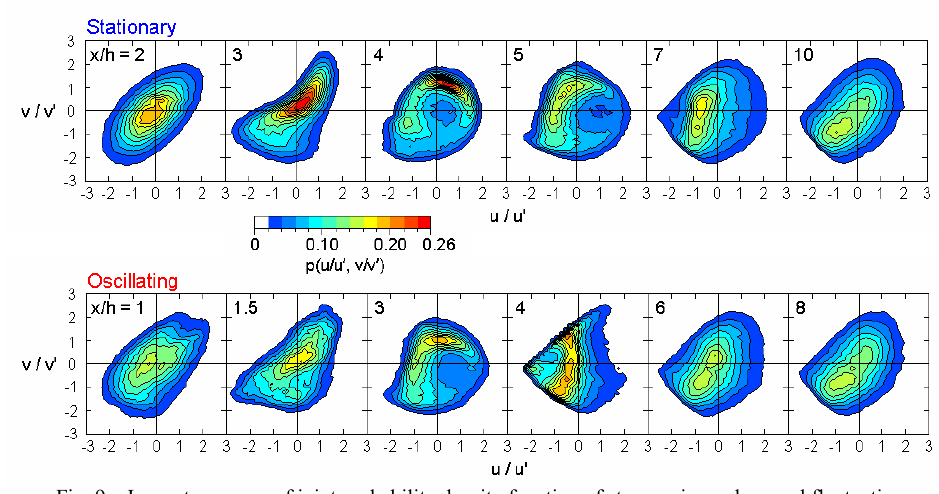
Fig. 9 Isocontour maps of joint probability density function of streamwise and normal fluctuating